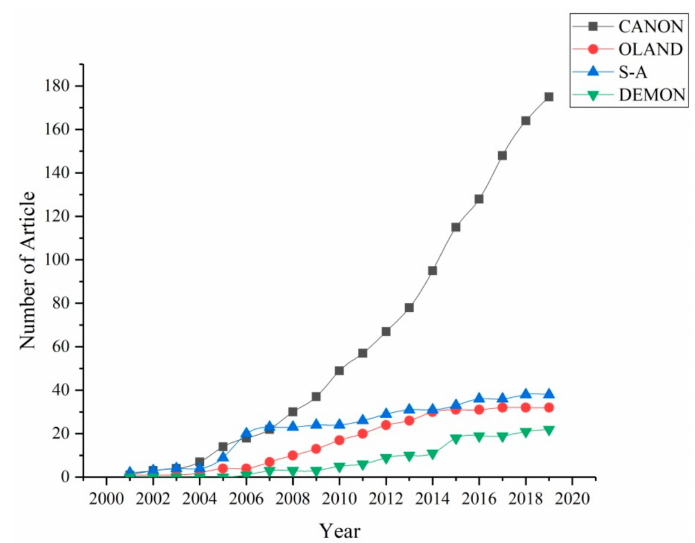
Figure 1. Common anammox process types (Data source: Web of Science).